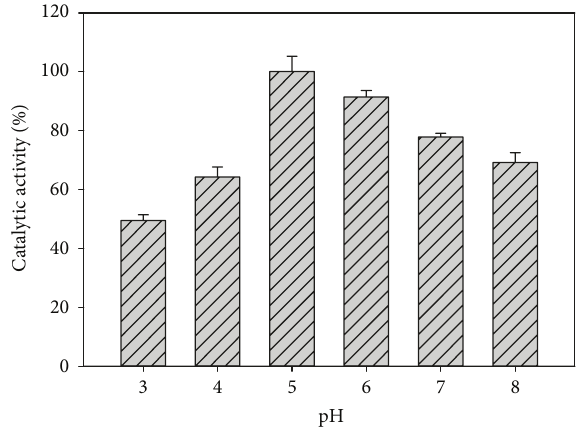
Figure 2: PP-PVA/FeTFPP oxidizes hydrogen sulfide with a pH- dependent behavior. 10mg of catalyst reacted in the presence of 25 mM buffer solution, 10mM NaHS, and 45mM H 2 O 2 (1mL final volume) at 25 ∘ C for 24h. Results are expressed as sulfide conversion (i.e., sulfide removal regardless of the chemical nature of the oxidation product(s)) ( 𝑛 = 5